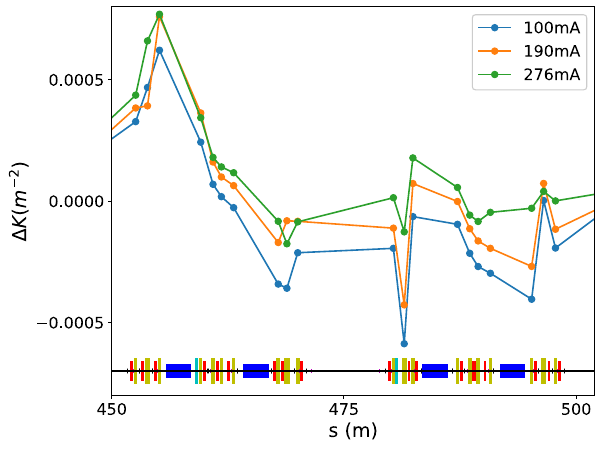
FIG. 11. Quadrupoles ’ virtual variations at different beam currents obtained with Eq. (11) for a NSLS-II supercell. They can be interpreted as horizontal focusing quadrupolar wakefields that gradually increase with the beam current, which provides a guide for localizing the impedance distribution around the ring.